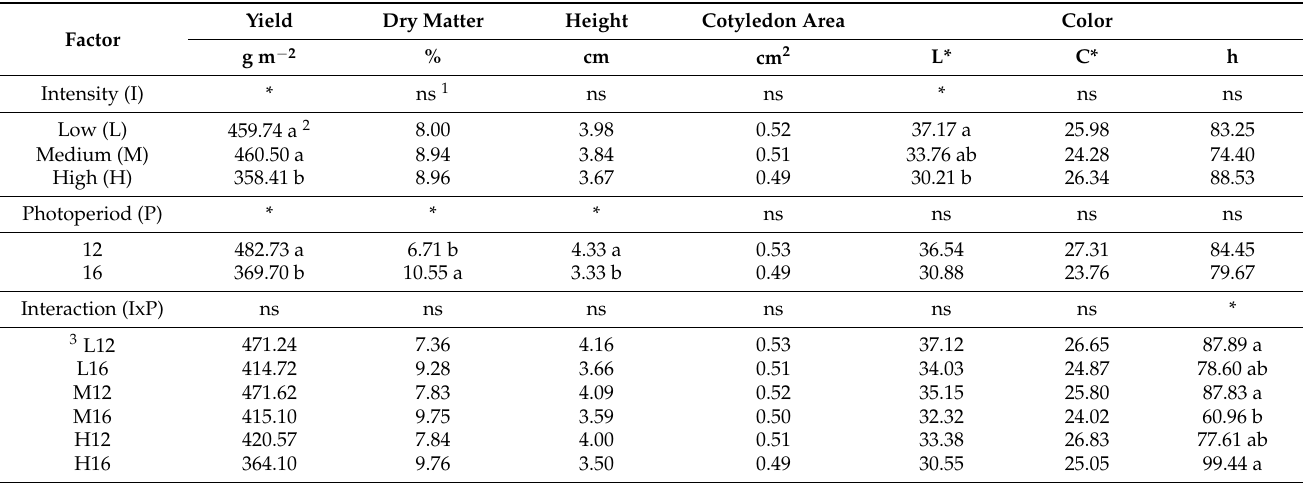
Table 2. Agronomic characteristics and color (L* = lightness; C* = Chroma, and h = hue) of beet microgreens under different light treatments. Values are the mean of 3